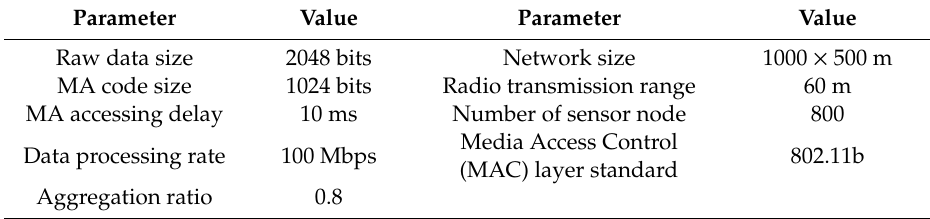
Table 3. Setting of simulation